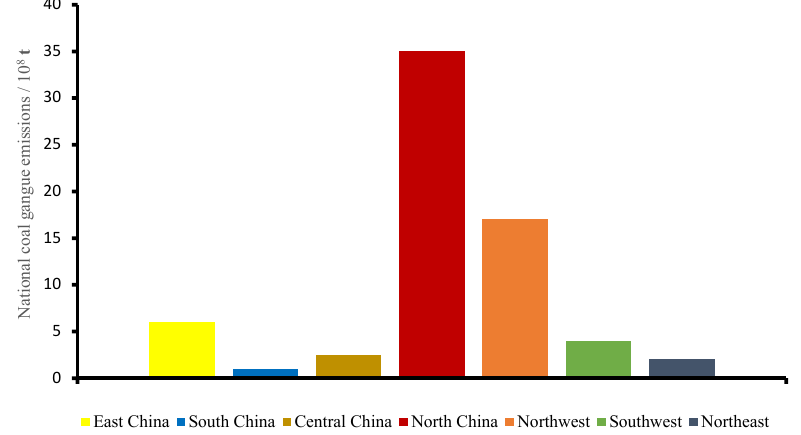
Figure 1. Cumulative emissions of coal gangue from various regions of the country.